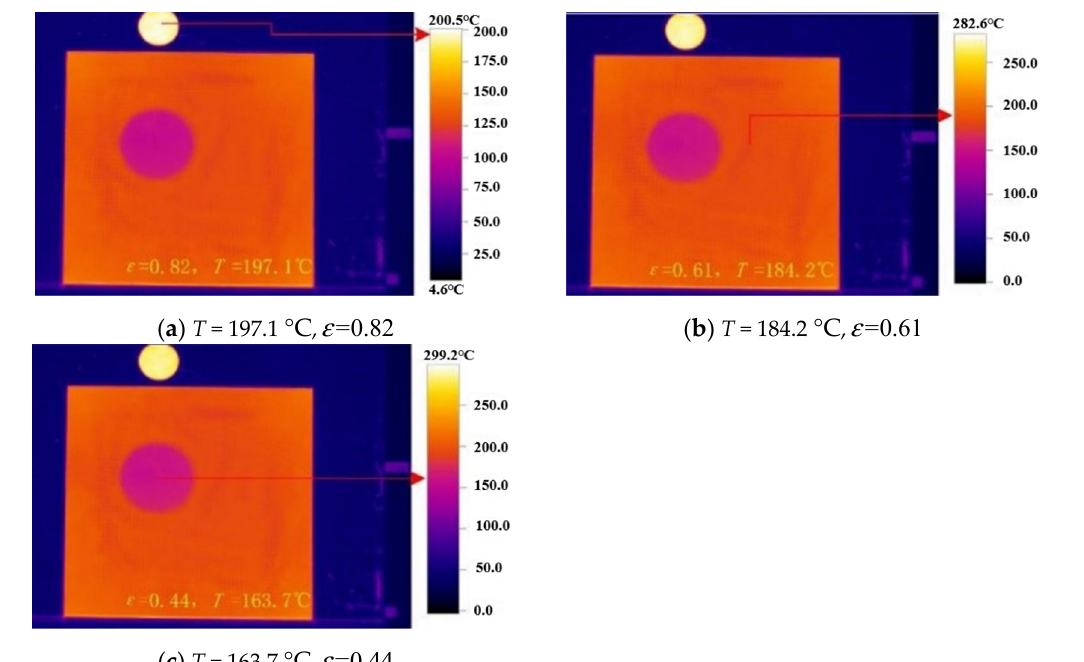
Figure 10. Set the temperature of the constant temperature heating table to 200 °C.